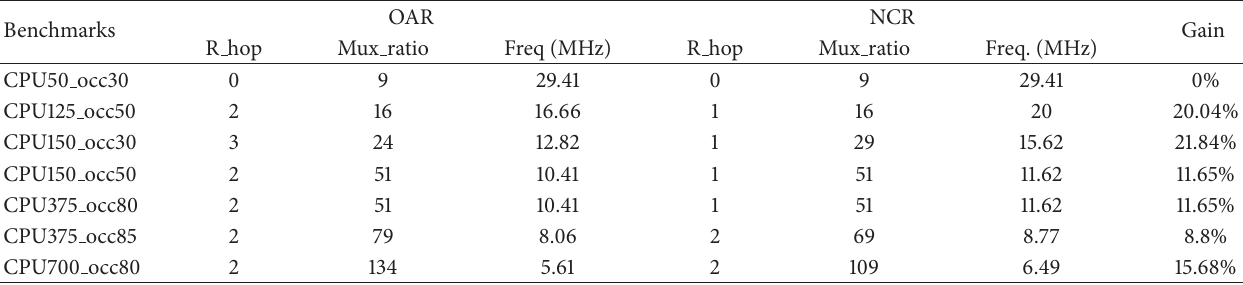
Table 3: Comparison between OAR and NCR strategies on system